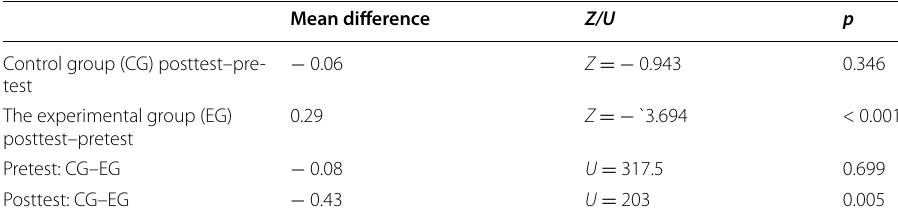
Table 6 Comparisons of the overall